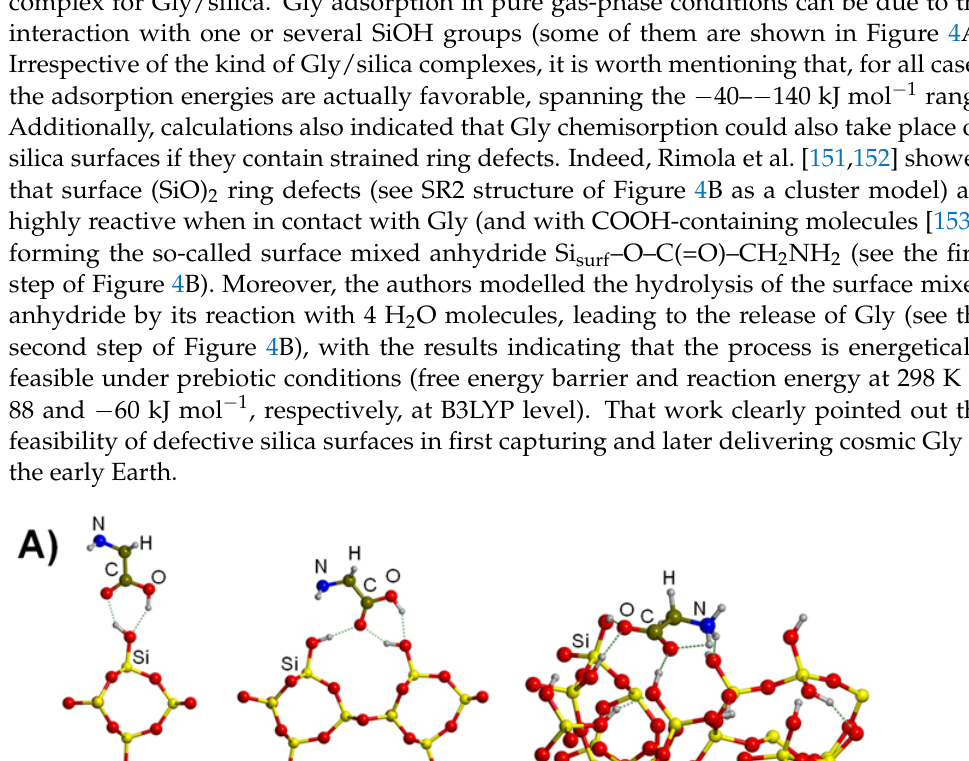
Figure 5. ( A , B ) Interaction of Gly with a silicate surface adopting different adsorption modes (adapted from Refs. [154,155]). ( C ) Sanidine surface model containing an acidic Lewis and Bronsted site, and the interaction of Gly with these surface sites (adapted from Refs. [158,159]).